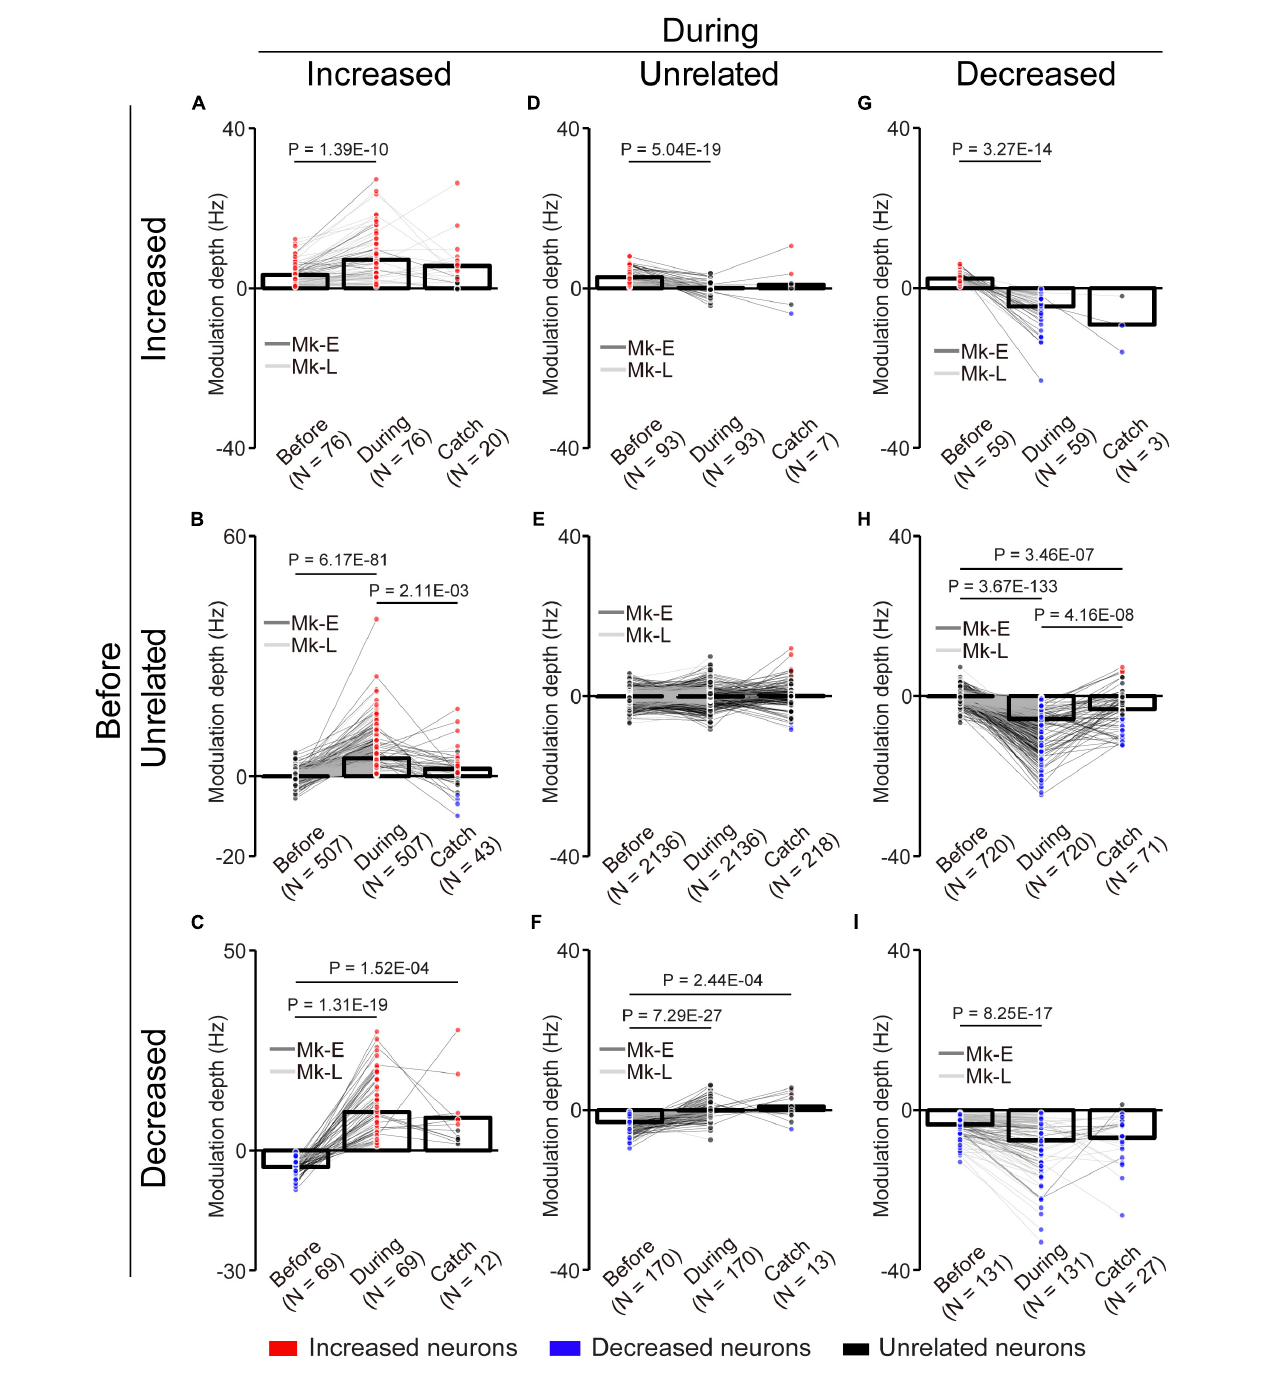
FIGURE6 Change of the MDs of unlinked neurons with the corticospinal interface. (A) Neurons maintained their properties as “increased” type before and during the corticospinal interface trials. (B) Neurons changed their properties from “unrelated” to “increased” type. (C) Neurons changed their properties from “decreased” to “increased” type. (D) Neurons changed their properties from “increased” to “unrelated” type. (E) Neurons maintained their properties as “unrelated” type. (F) Neurons changed their properties from “decreased” to “unrelated” type. (G) Neurons changed their properties from “increased” to “decreased” type. (H) Neurons changed their properties from “unrelated” to “decreased” type. (I) Neurons maintained their properties as “decreased” type. Bars and circles indicate the MDs of mean values and individual neurons, respectively. Colors (red: increased neuron, black: unrelated neuron, blue: decreased neuron) of the circles represent the neuron type sorted in each condition (i.e., experiments of before and during the corticospinal interface and catch trials). Black horizontal lines represent significant differences ( P < 1.67 × 10 − 2 by paired t -test with Bonferroni’s correction for post hoc multiple comparisons). Experiments with at least nine trials were included in each condition.